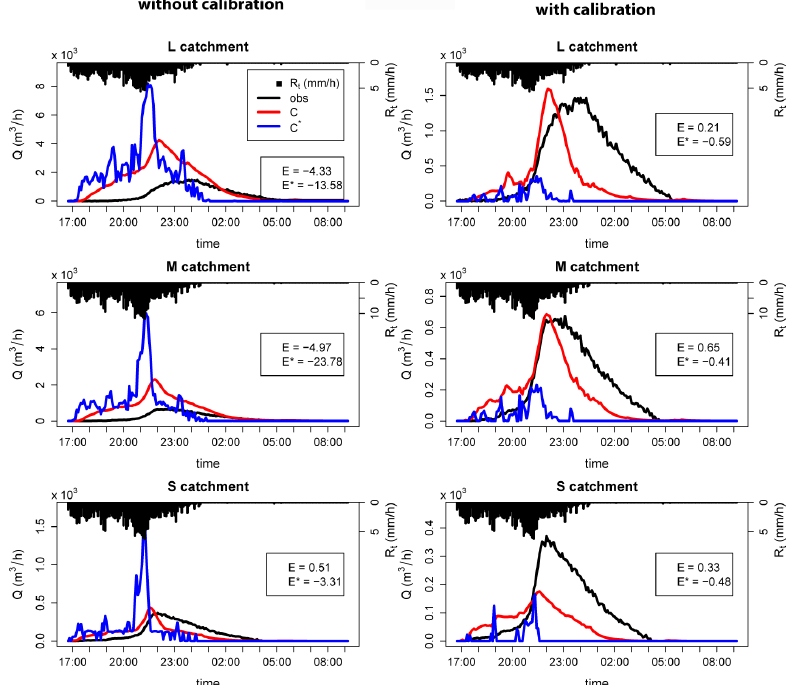
Fig. A2. Same as in Fig. A1, for an event on 7 April